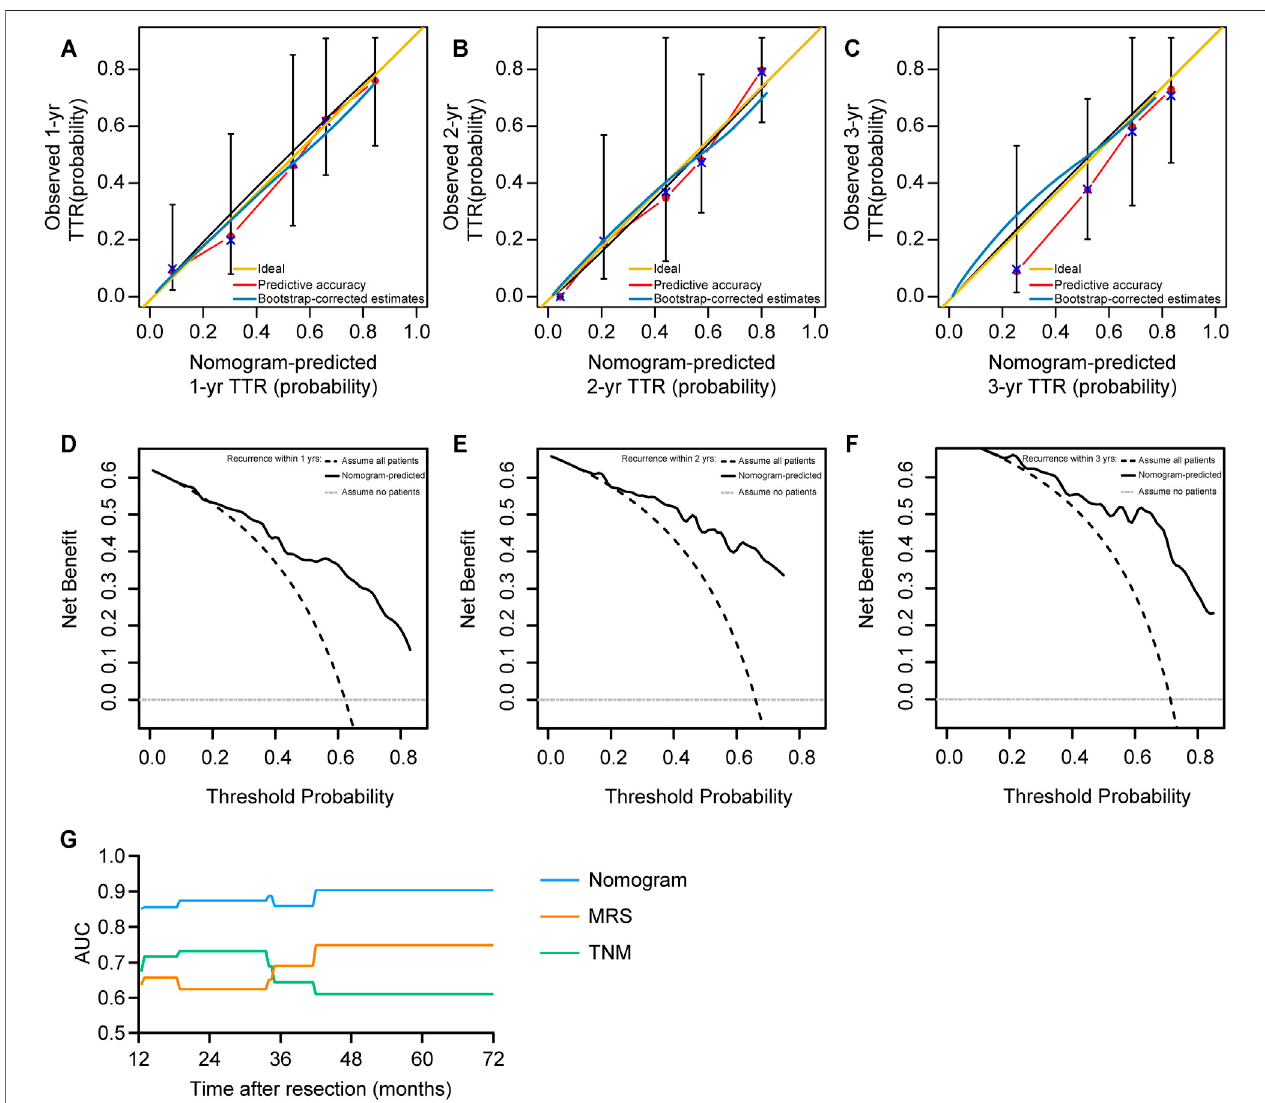
FIGURE4| ThecalibrationandclinicalusefulnessoftheMRS-basednomogram. (A – C) ThecalibrationcurvesforpredictingiCCApatients ’ postoperative1,2,and 3 years recurrence. (D – F) Decision curve analysis (DCA) of the clinical usefulness for this TTR nomogram. (G) The AUC values of the ROC curve analysis for the MRS- based nomogram at different time points was compared with that of the MRS alone or the TNM staging system by time-dependent ROC curves.